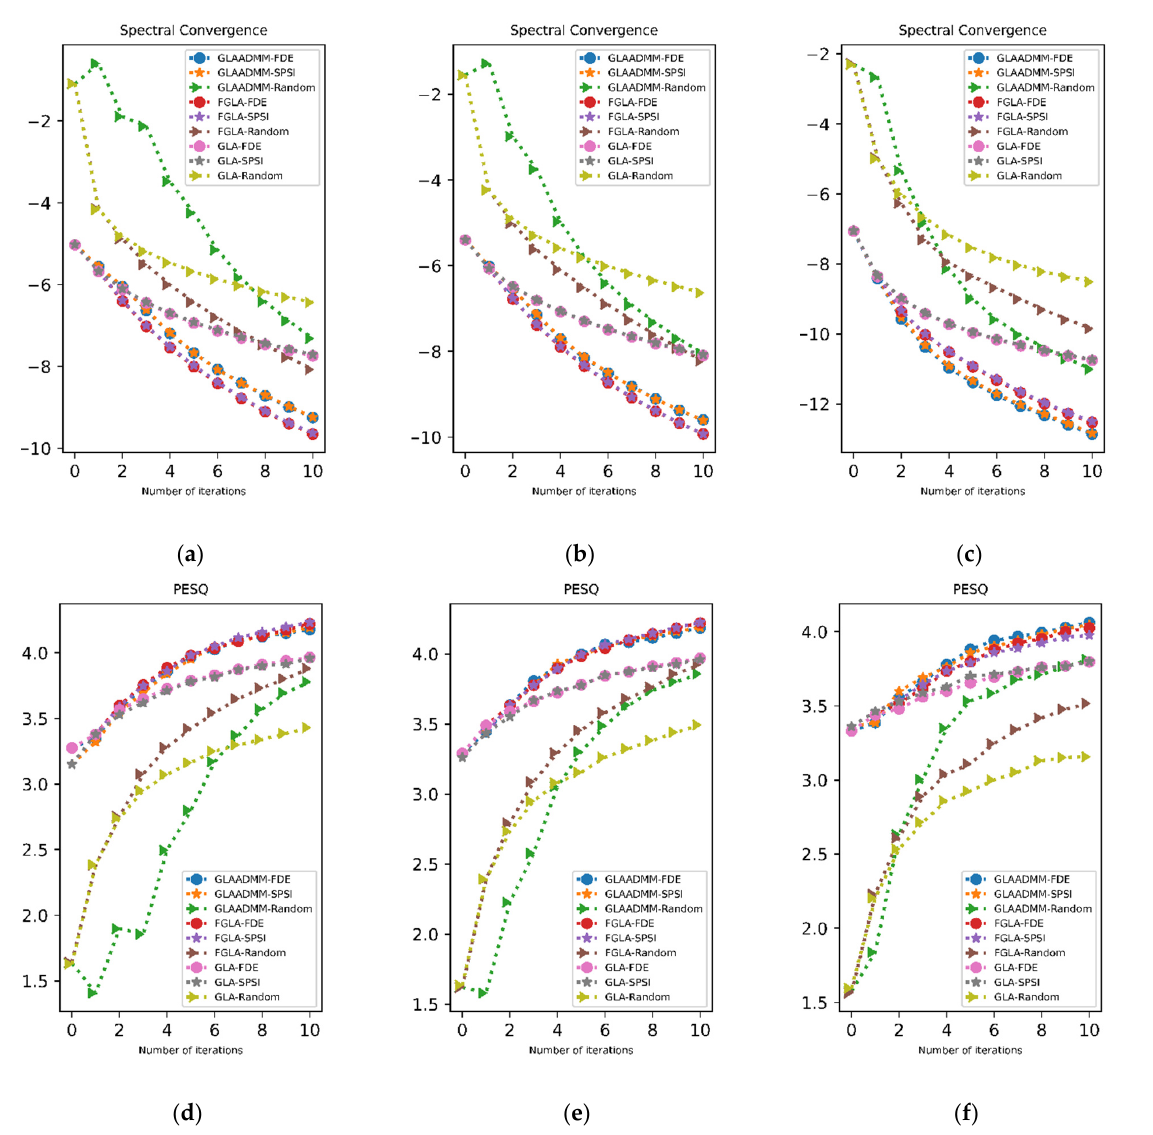
Figure 6. GLA, FGLA, and GLAADMM comparison with SPSI, FDE method, and random phase values as initial phases: ( a ) SC for 10 iterations for hop size = 64, overlap = 87.5%; ( b ) SC for 10 iterations for hop size = 128, overlap = 75%; ( c ) SC for 10 iterations for hop size = 256, overlap = 50%; ( d ) PESQ for 10 iterations for hop size = 64, overlap = 87.5%; ( e ) PESQ for 10 iterations for hop size = 128, overlap = 75%; ( f ) PESQ for 10 iterations for hop size = 256, overlap = 50%.